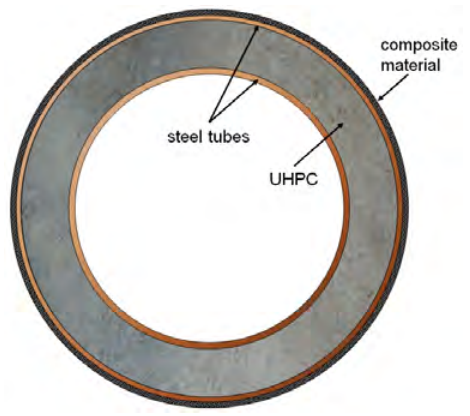
Figure 1. UHPC sandwich structure with composite coating,